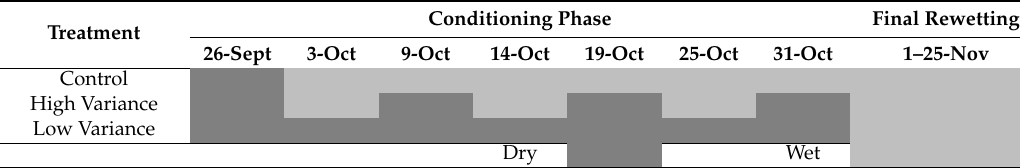
Table 1. Control, high variance and low variance samples were dried and rewetted as shown. Between 3–9 October, the experiment was suspended for one day, and the samples were moved indoors to protect them from the heavy rainfall and wind caused by Hurricane